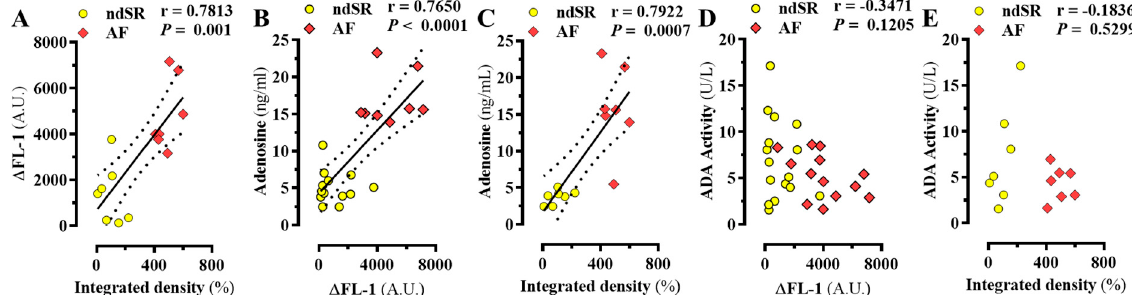
Figure 5. Correlation of atrial A 2A R density and peripheric adenosinergic system. Correlation between the relative A 2A R density in the right atrium determined by immunoblot (Integrated density, see Figure 1B) and the specific MRS7396 binding ( ∆ FL-1) to PBMCc ( A ), adenosine content ( C ) and ADA activity ( E ) from ndSR (yellow) and AF (red) patients. Also, the correlation between the specific MRS7396 binding ( ∆ FL-1) to PBMCc and the adenosine content ( B ) and ADA activity ( D ) from ndSR (yellow) and AF (red) patients was assessed. The correlation coefficient (r) was calculated using the Pearson (two-tailed correlation) test.